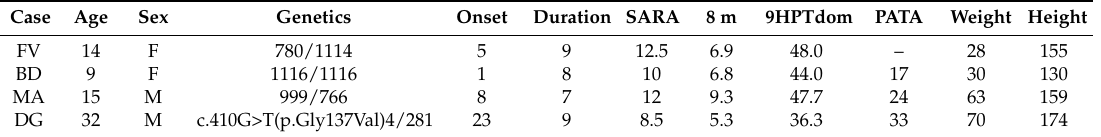
Table 1. Clinical data of patients with